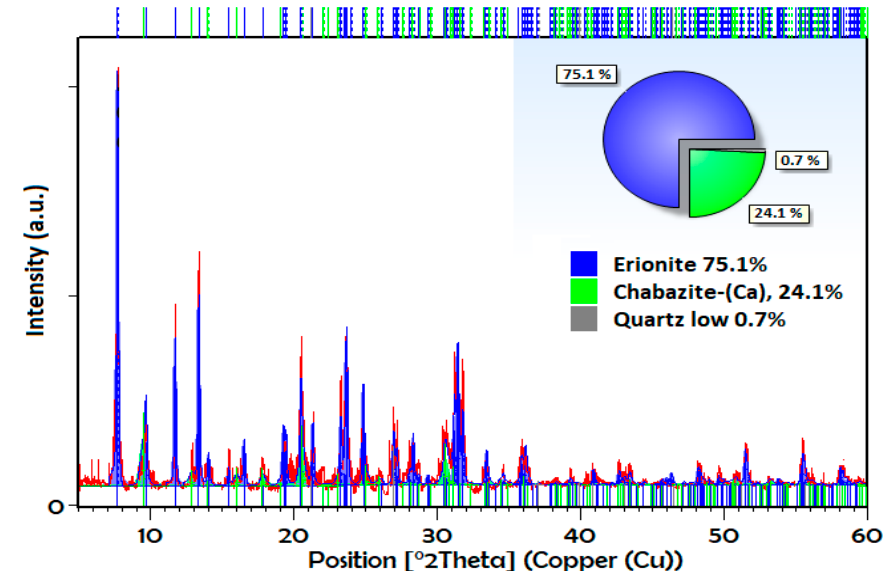
Figure 2. X-ray powder diffraction pattern of natural erionite refined by Rietveld method.